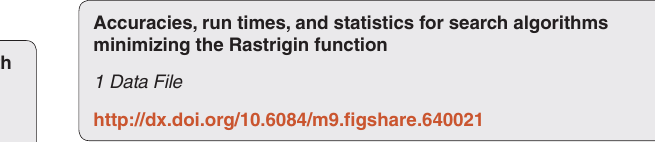
times of the hill climbing and Nelder-Mead methods when the algorithm accurately converged and when the same algorithm did not accurately converge. Both the hill climbing method (p = 0.140 > 0.05)